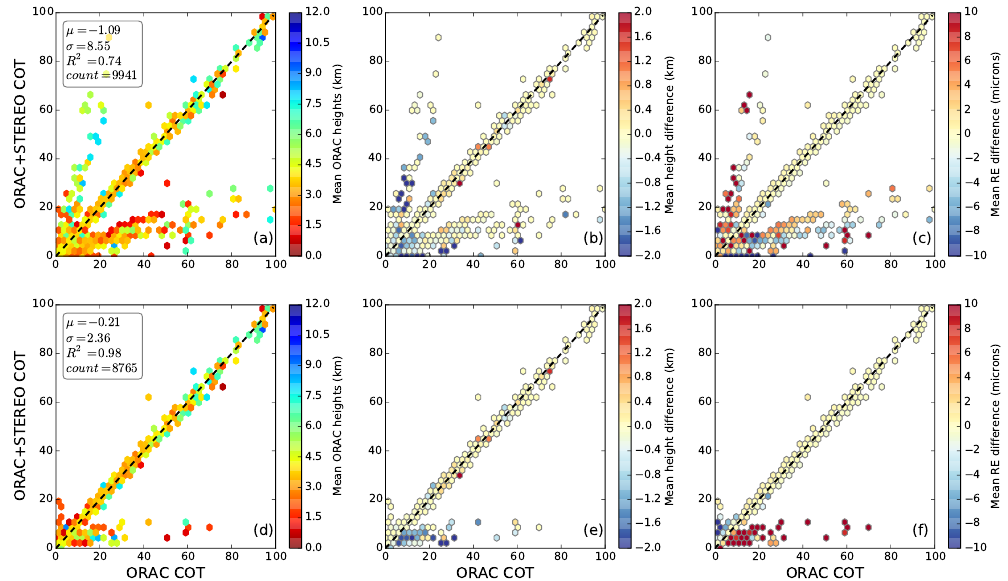
Figure 10. Joint histograms of COT as retrieved by ORAC and by ORAC + stereo. Plots (a–c) show the samples for all single-layer clouds over water (number of layers determined by CALIOP and open water determined by AMSR-E). Plots (d–f) show the subset of the sample where the ORAC and ORAC + stereo phases are in agreement.